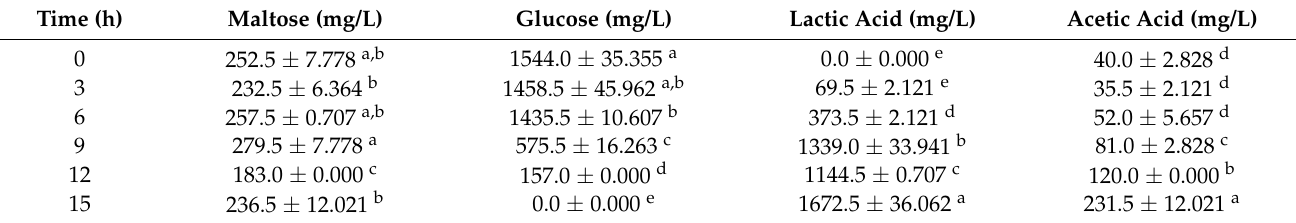
Table 9. Results obtained in the examination of sugar and organic acid in the mixed-culture fermentation of the STF substrate. Time